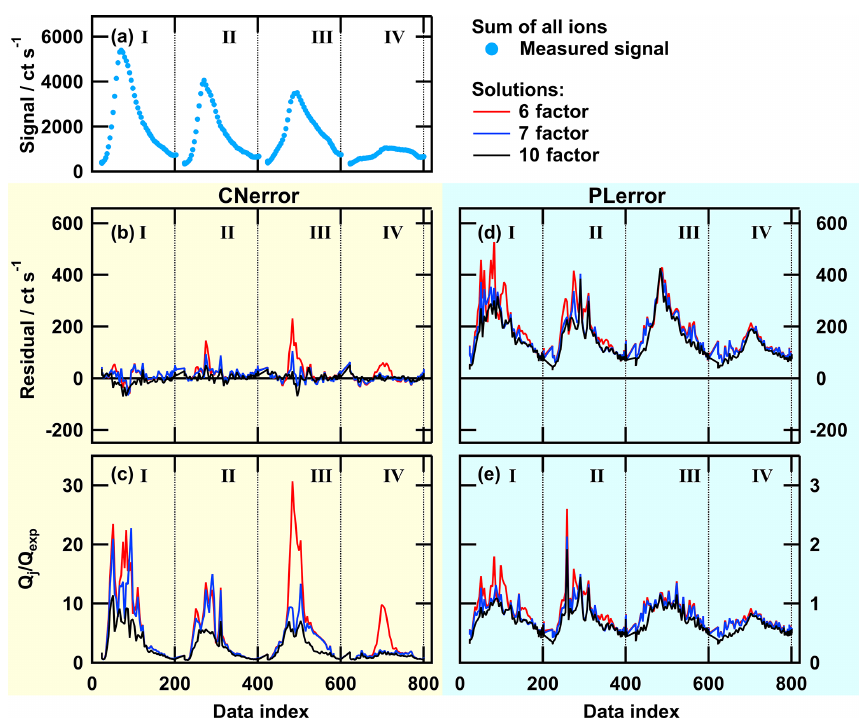
Figure 4. Total ion thermogram (a) , residuals (b, d) , and Q j /Q exp values (c, e) as time series for solutions with 6, 7, or 10 factors for PMF run with CNerror ( b, c – yellow background) and PLerror ( d, e – blue background). The data set contains thermogram scans for the high-O : C SOA particles from the following sampling conditions: dry – t evap = 0 . 25h (I); dry – t evap = 4h(II); wet – t evap = 0 . 25h (III); and wet – t evap = 4h (IV). Note that the y -axis scaling is the same in panels (b) and (d) , but it is 10 times smaller in (e) than in (c)